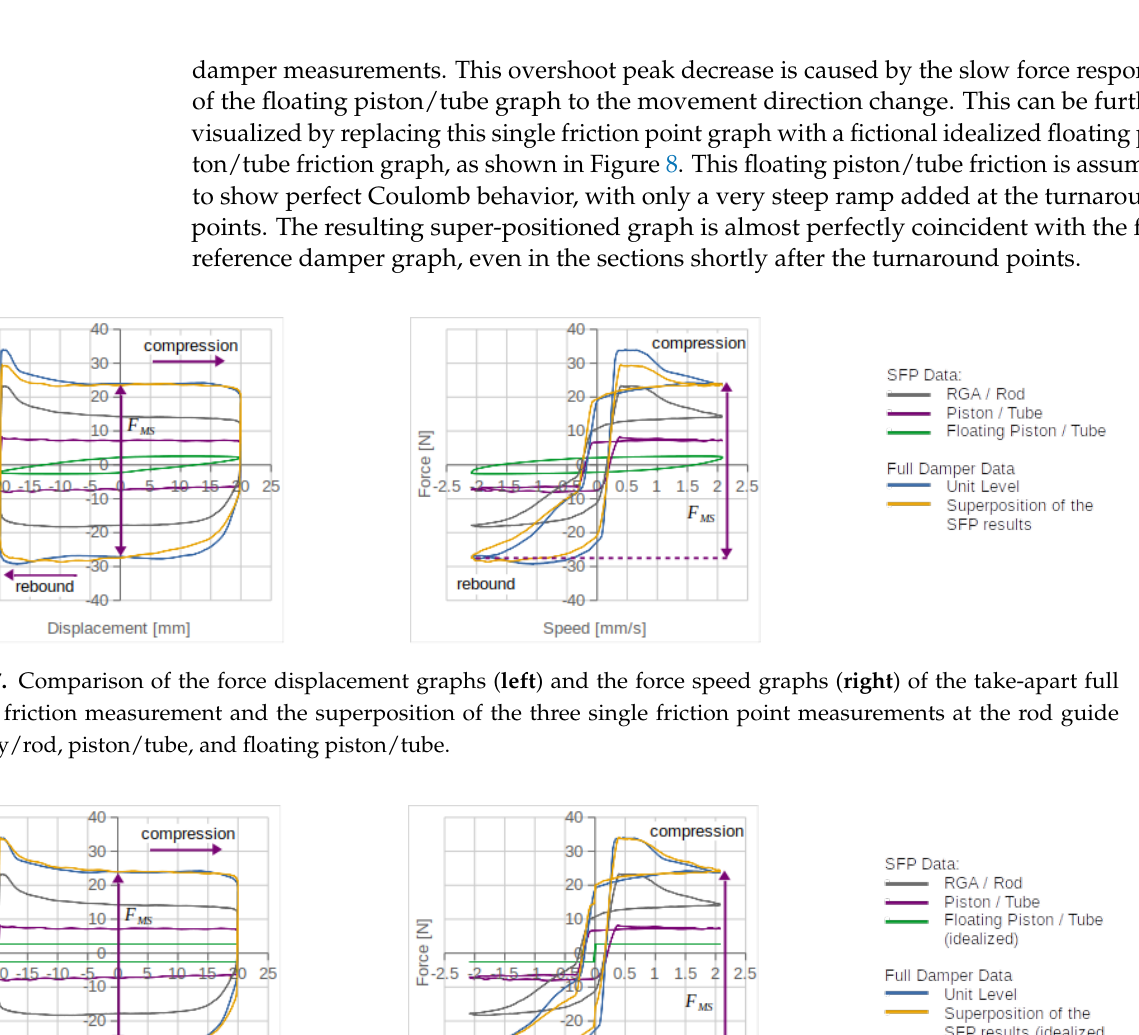
9 compensate for the general force increase during compression due to the decreasing gas volume. All pre-conditioning and measurement sequences are performed as introduced